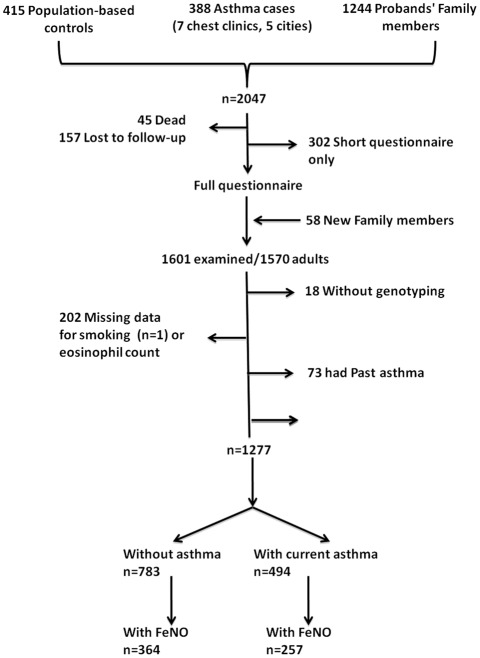
Flowchart of the studied population.